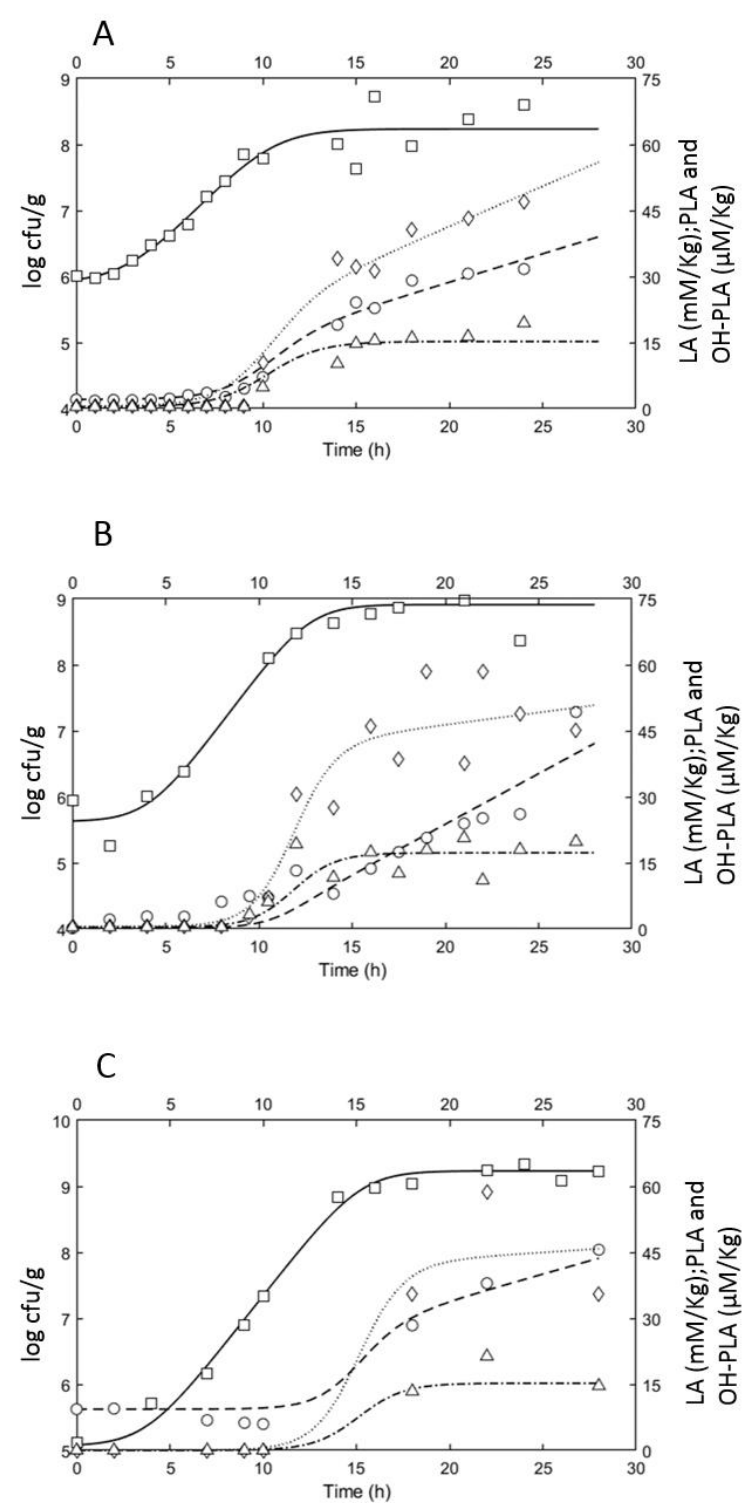
Figure 2. Comparison between the fitted kinetics of L. plantarum ITM21B growth and of organic acid production in liquid sourdough Bio21B-1 ( A ), Bio21B-2 ( B ), and Bio21B-3 ( C ), and experimental observations ( L. plantarum log cfu/g: (cid:3) , straight line; lactic acid (mM/kg) (LA): dashed line, ; phenyllactic acid ( µ M/kg) (PLA): dotted line, ♦ ; hydroxy-phenyllactic ( µ M/kg) (OH-PLA): dash-dotted line, ∆ ) during fermentation.